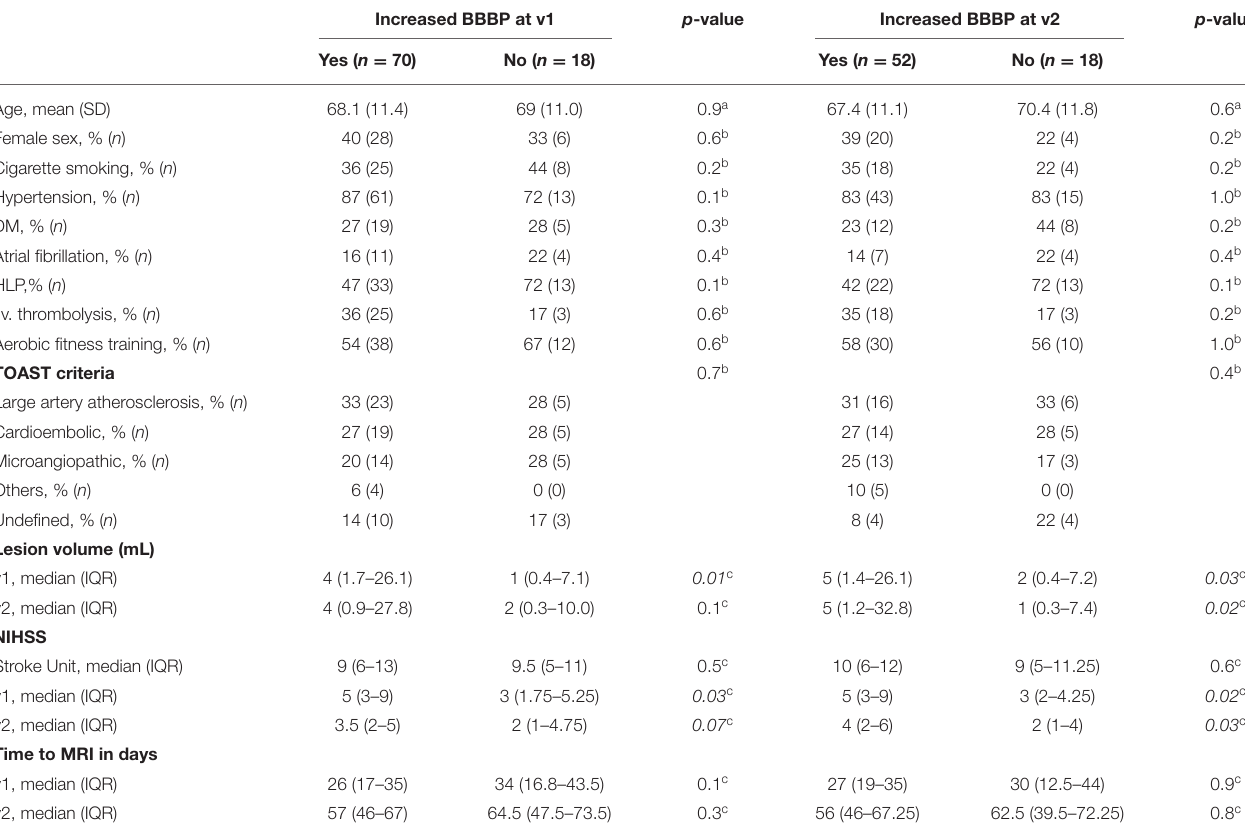
TABLE 2 | Patient demographics stratified by increased blood-brain barrier permeability (BBBP) at MRI before (v1) or after (v2)